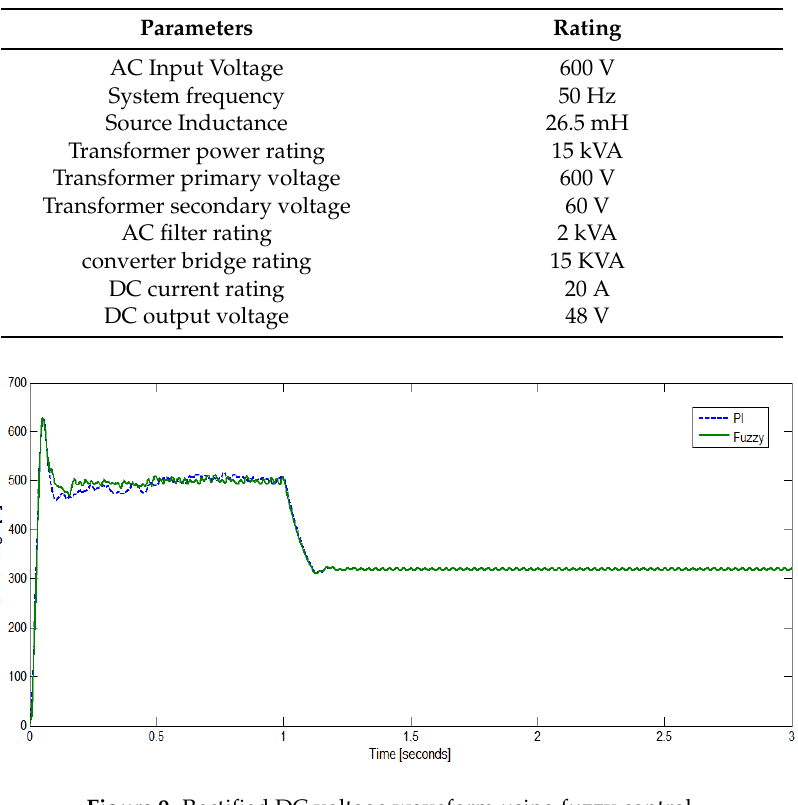
Table 1. System parameters.